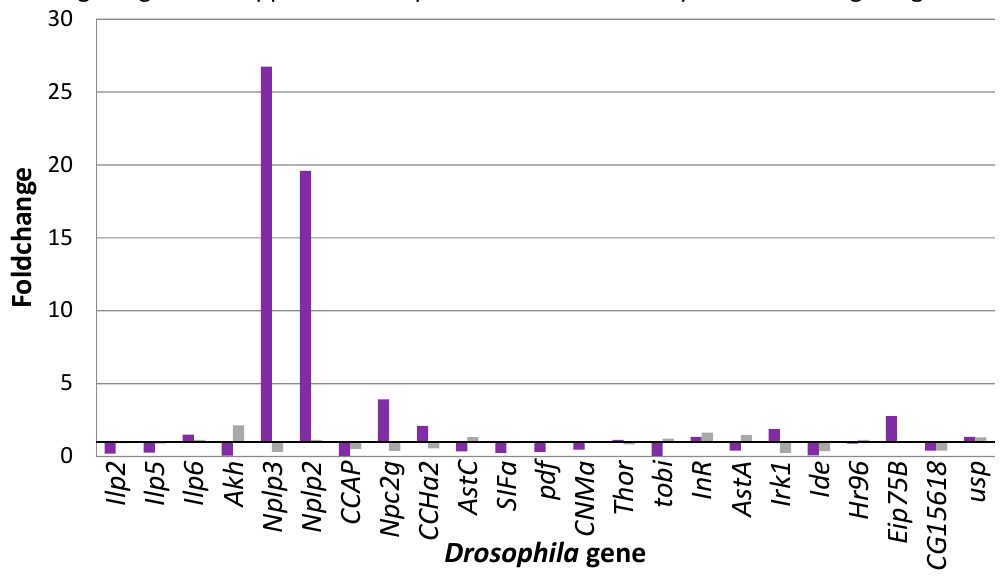
Figure 5. Foldchange in neuropeptide gene expression of wild-type Drosophila melanogaster reared for 12 days on a high-sugar diet, supplemented or not with 3% hydro-methanolic extract (E3). Data reported as average of triplicate experiments, as ratio of gene expression values on high-sugar diet to gene expression levels on normal diet control.